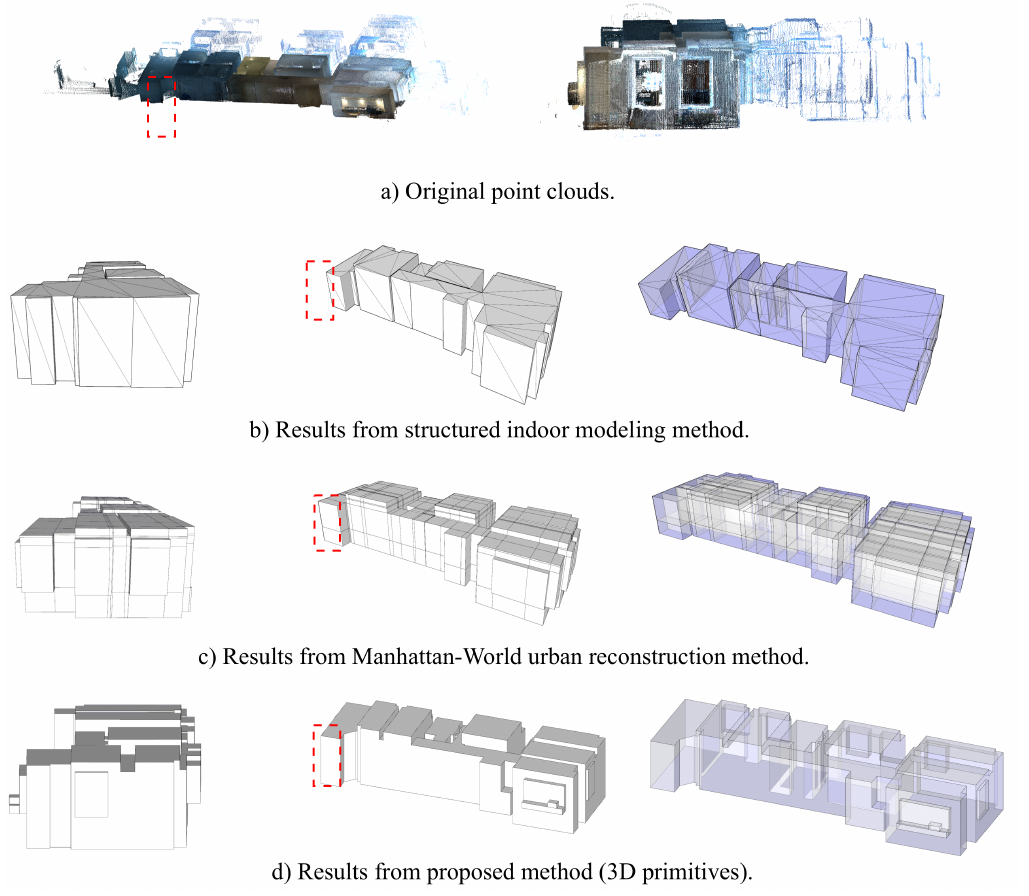
Figure 27. Comparisons with different methods: ( a ) the original point clouds; ( b ) the results from structured indoor modeling method (Ikehata et al. [8]); ( c ) the results from Manhattan-World urban reconstruction method (Li et al. [10]); ( d ) the results from the proposed method. From left to right: Side view, front view, and transparent